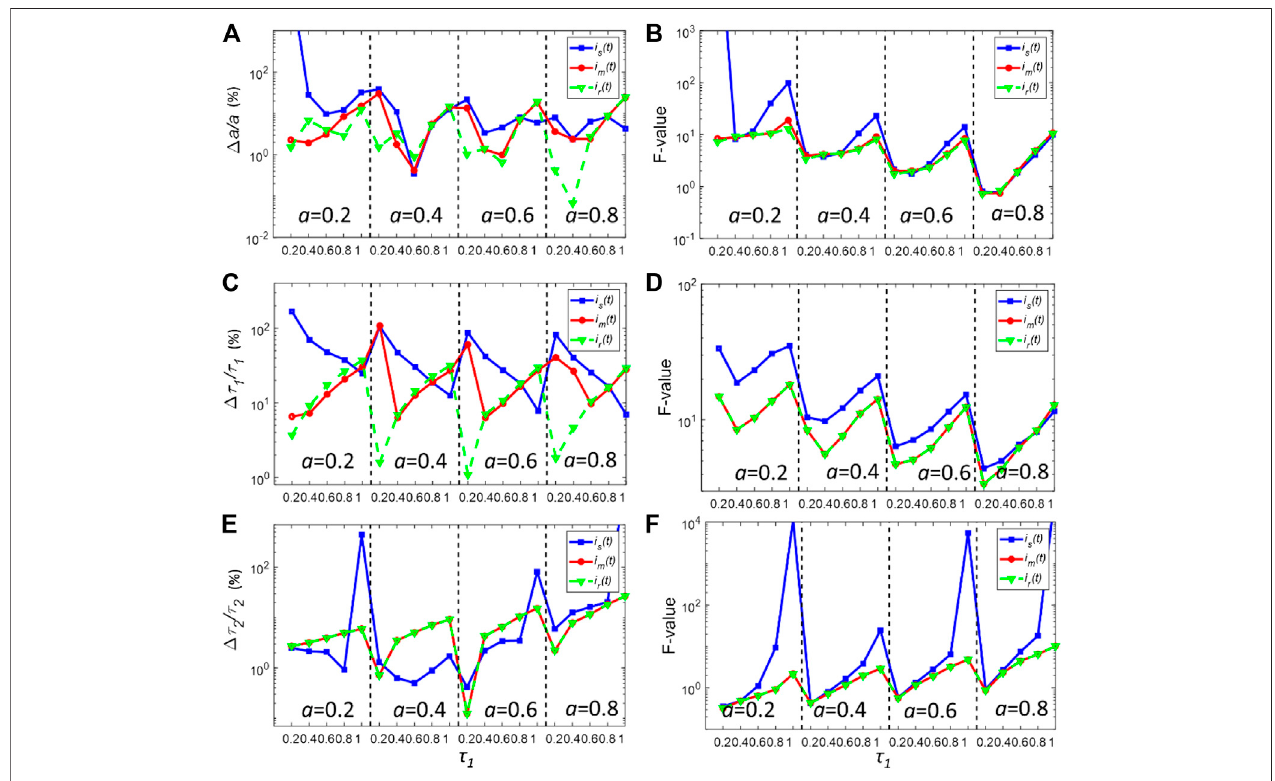
FIGURE 4 | (A,C,E) Normalized bias plots for a , τ 1 and τ 2 when N c (cid:2) 5000. The corresponding F -value plots are depicted in (B,D,F) .